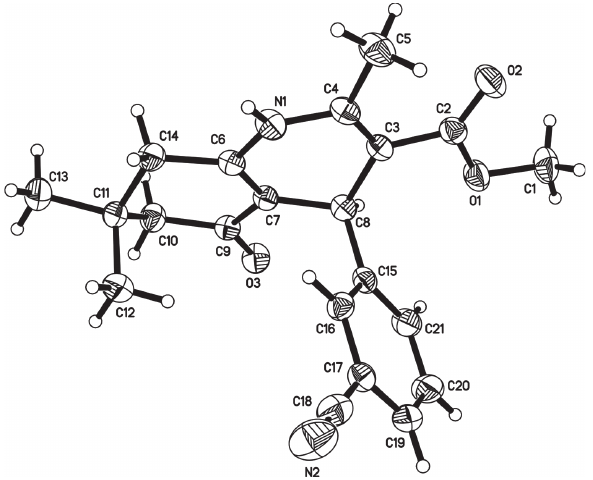
Table 1: Data collection and handling.